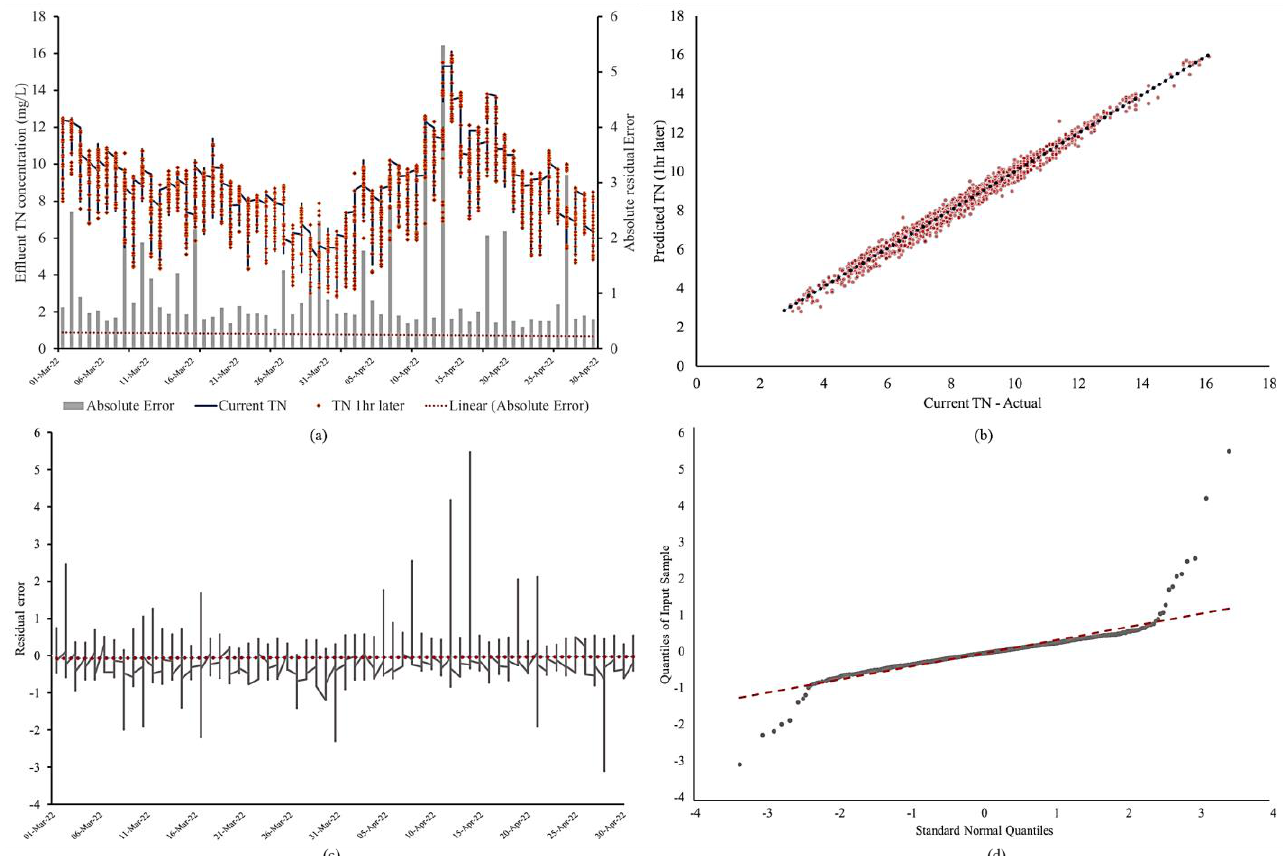
Figure 10. One-hour ahead prediction performance visualization of ( a ) a time series of predicted effluent TN, ( b ) a scatter plot of predicted and current TN values, ( c ) the generated residuals, and ( d ) the quantile – quantile plot for model residuals.